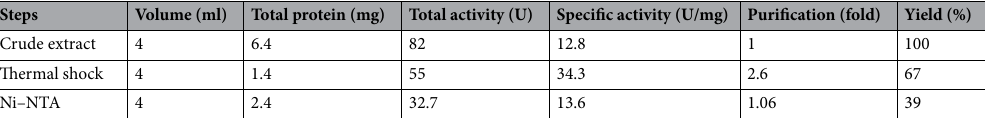
Table 2. Data of CelC307 purification using Ni–NTA chromatography and single-step thermal shock.